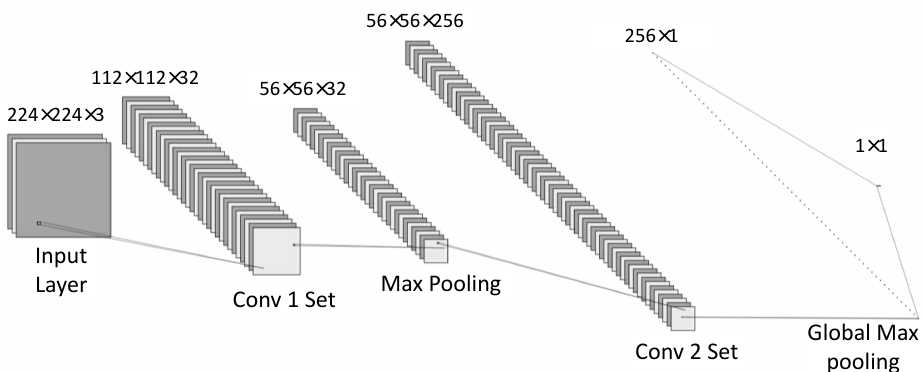
Figure 1. The overall architecture of the proposed approach.